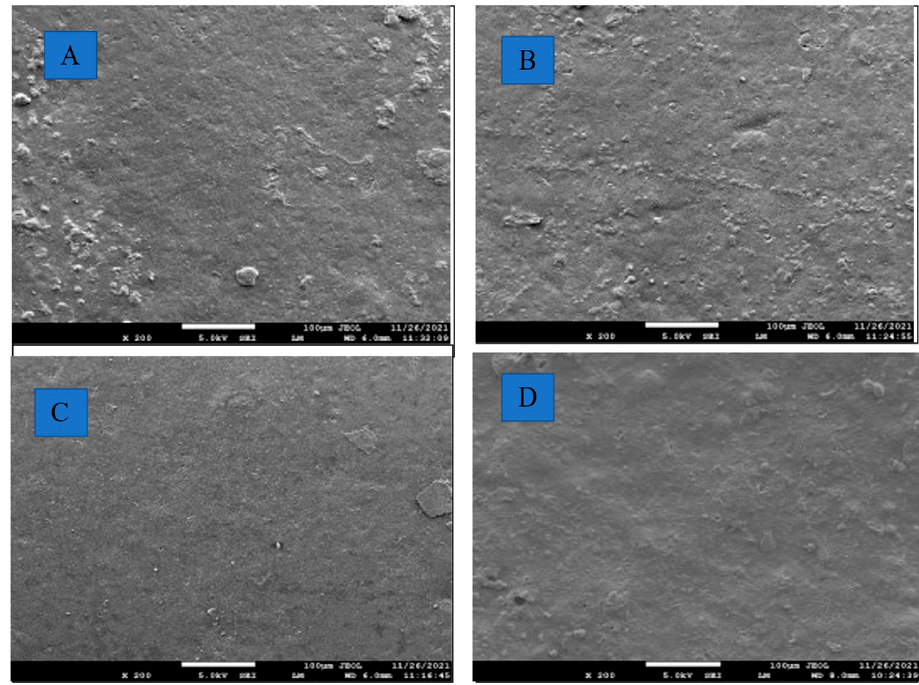
Figure 6. Morphological properties of native and modified cross-linked lotus seed starch films at 200 × magnification. ( A ) Native LSF, ( B ) CL-LSF-1, ( C ) CL-LSF-3, ( D ) CL-LSF-5.